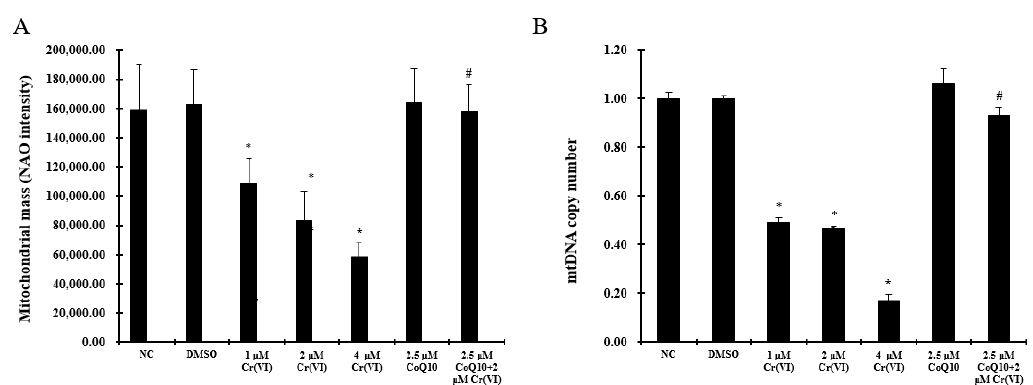
Figure 3. Cr(VI) triggers significant mitochondrial biogenesis loss. ( A ) NAO staining was used to analyze the mitochondrial mass using a microplate reader; ( B ) quantitative real-time PCR analysis was applied to detect the mtDNA copy number. The data are presented as mean ± SD ( n = 6). * p < 0.05 compared with the control group; # p < 0.05 compared with the 2 µ M Cr(VI) treatment group.